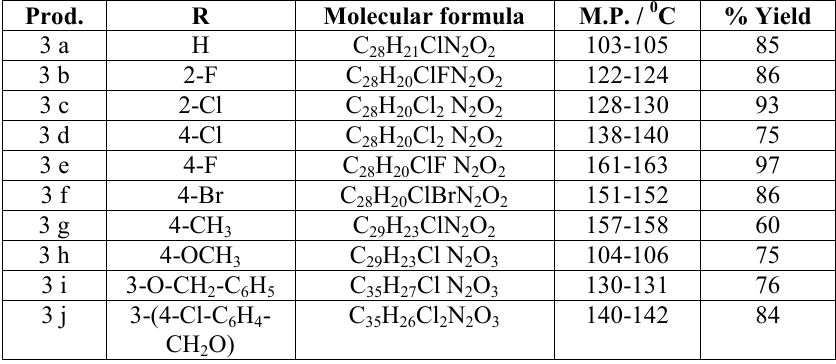
Table 1. Melting points and yields for the prepared chalcones (3a-j). Prod. R